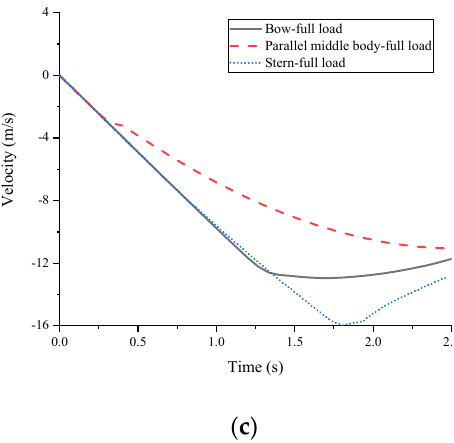
Figure 26. Velocity of each section at different loading conditions: ( a ) Lightship weight; ( b ) half load; ( c ) full load.